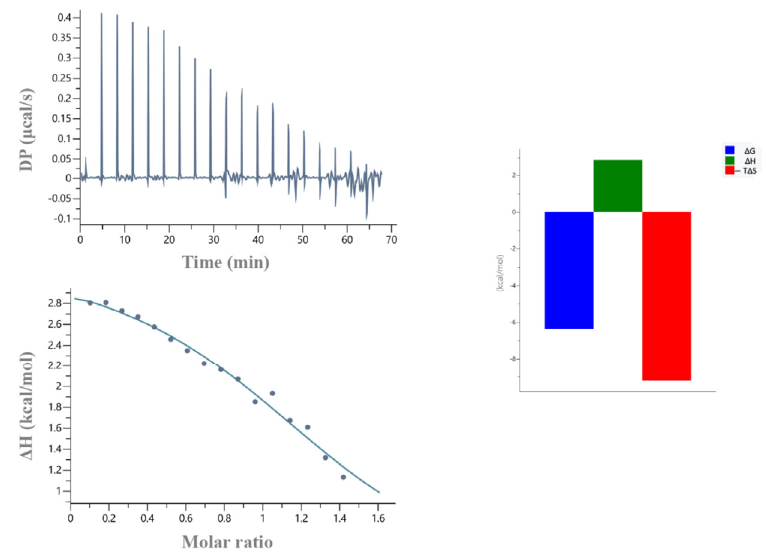
Figure 11. ITC data for the titration of UBCH5B into Arkadia 90 aa.